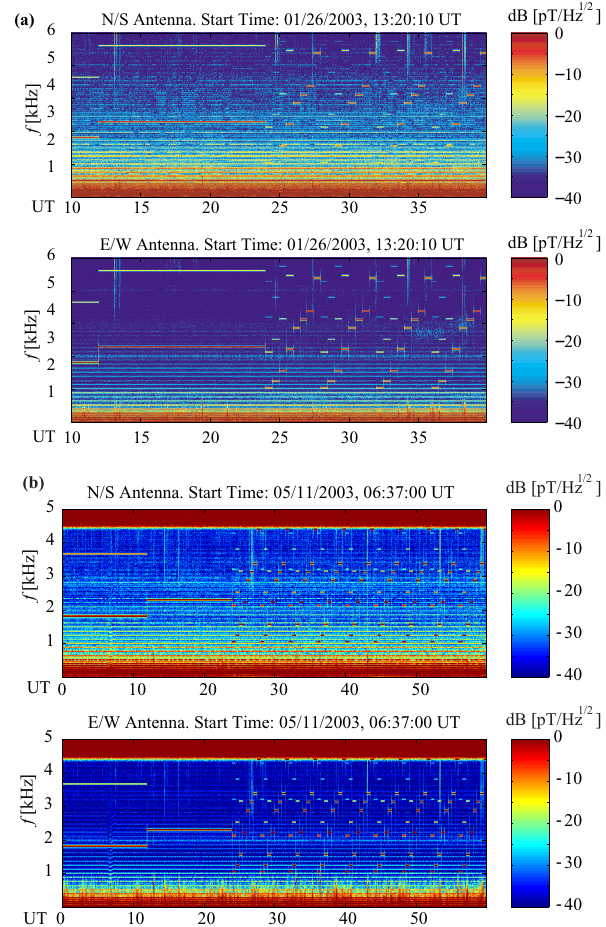
Fig. 12. Ground observations of the ELF/VLF HAARP generated signal at Chistochina. (a) Measured signal during 26 January 2003, starting at 13:20:10 UT. (b) Measured signal during 11 May 2003, starting at 06:37:00 UT. Each panel in both displays corresponds to a different magnetic loop antenna, one being oriented to the ge- ographic north-south line and the other one oriented to the geo- graphic east-west line. In both cases strong ELF/VLF signals were recorded on the ground, indicating the presence of modulated elec- trojet currents in the ionosphere. The magnitude scale refers to mag- netic field intensity in